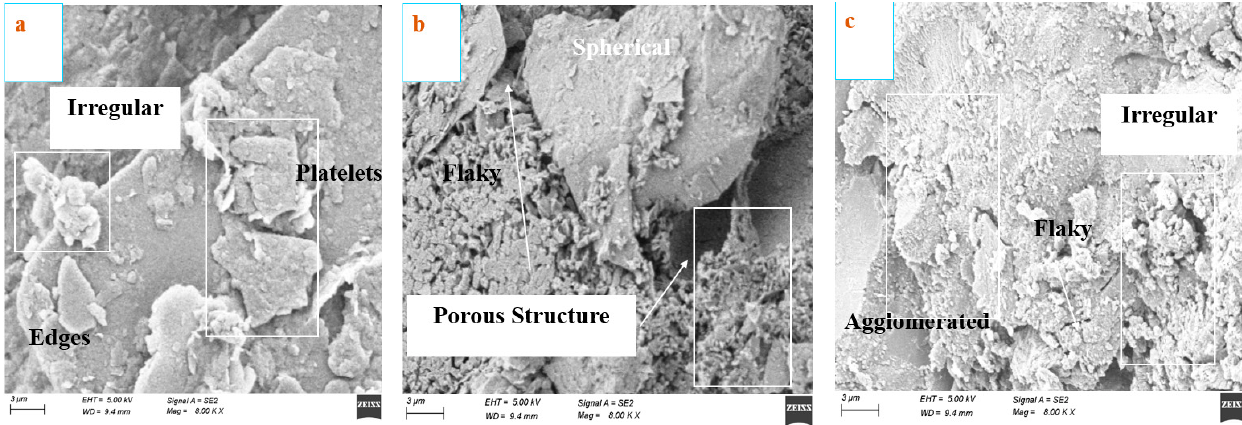
Figure 15. SEM micrographs of concrete with cementitious replacements at 10 µm: ( a ) RHA0 (con- trol), ( b ) RHA10, and ( c ) RHA20. ( b ) RHA10, and ( c )